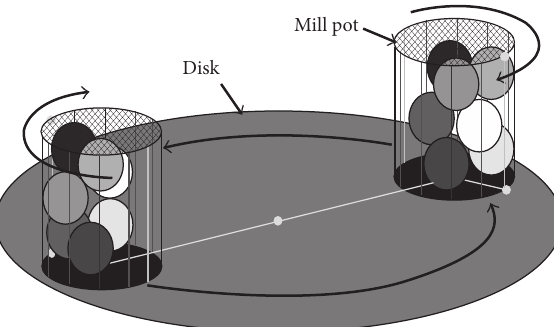
Figure 1: Schematic of the mechanics of a planetary ball